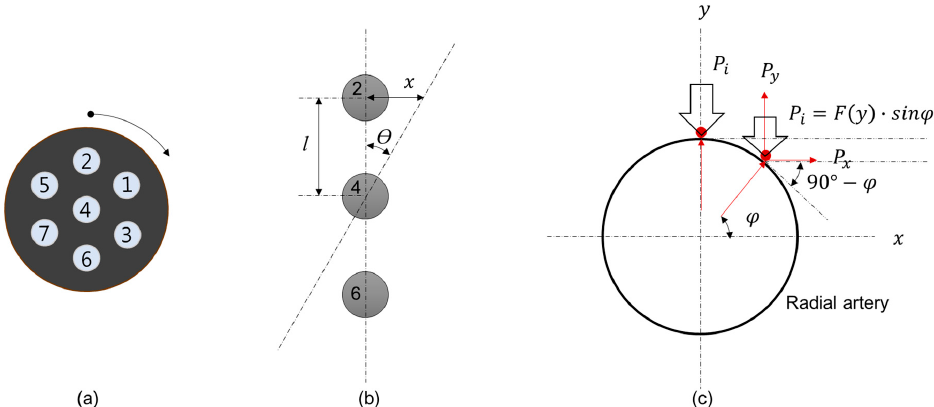
Figure 8. PSRP model and artery model pushed by channels: ( a ) PSRP of the decoupled circular type with rotation ( Ɵ ), ( b ) location change of channels rotated around channel four, and ( c ) the load on arterial vessel wall pushed by channels.